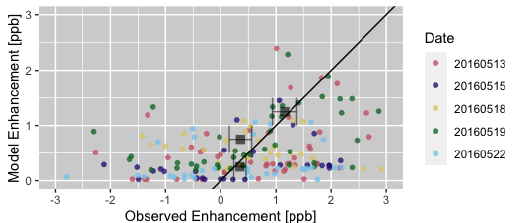
Figure 13. Optimized model correlation with the observations. The modeled background influence has been subtracted from both, showing just the enhancement in the total column due to local dif- fuse sources. The black line is a 1–1 line. These points represent 1h averages. Gray squares represent the mean observation values when model values are divided into 0.5ppb wide bins. The horizon- tal error bars represent the sample standard deviations for each bin. The means of the first (0.0–0.5ppb) and third (1.0–1.5ppb) bins are significantly distinct ( p = 0 . 003), demonstrating detection and quantification of the small enhancements in total column methane attributable specifically to diffuse emissions.